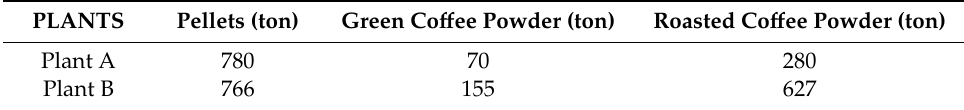
Table 2. Annual (2016) production of byproducts from the roasting process of green co ff ee in two analyzed